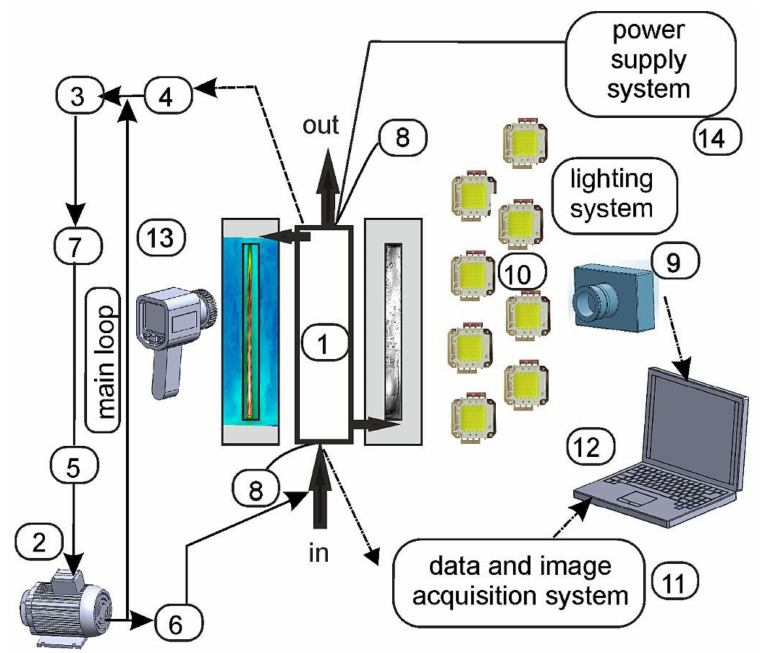
Figure 1. The main systems of the experimental setup: 1—test section, 2—gear pump, 3– compensat- ing tank/pressure regulator, 4—tube-type heat exchanger, 5—filter, 6—mass flow meter, 7—deaerator, 8—pressure sensor, 9—high-speed camera, 10—LEDs (400 W), 11—data acquisition station, 12—PC, 13—infrared camera, 14—power supply